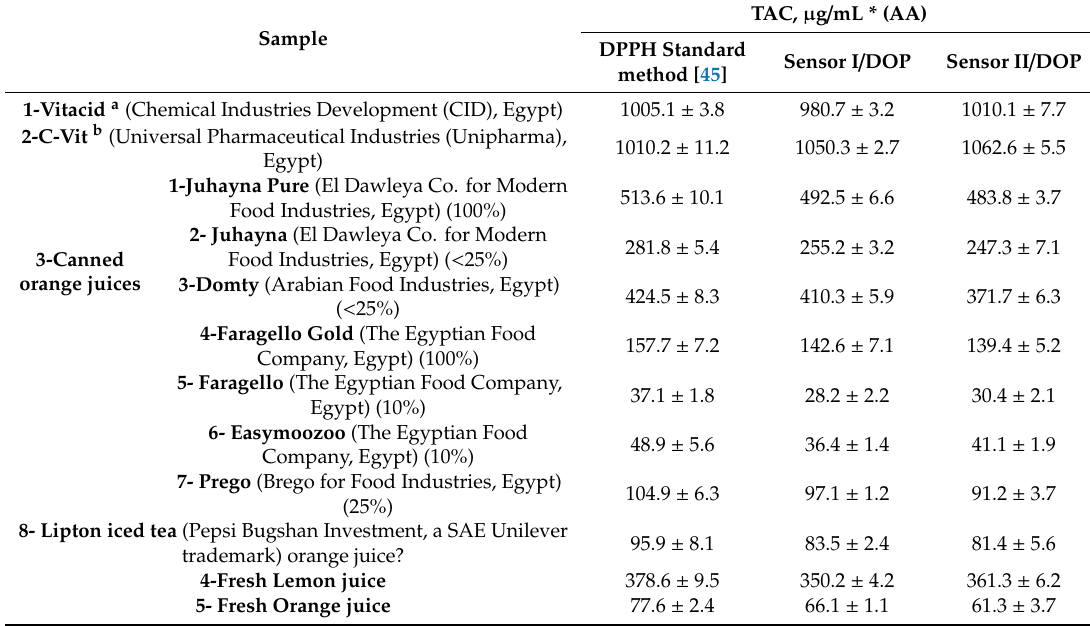
Table 5. Potentiometric assessment of TAC with 2,6-DCPIP-based sensors in commercial, fresh juices and pharmaceutical